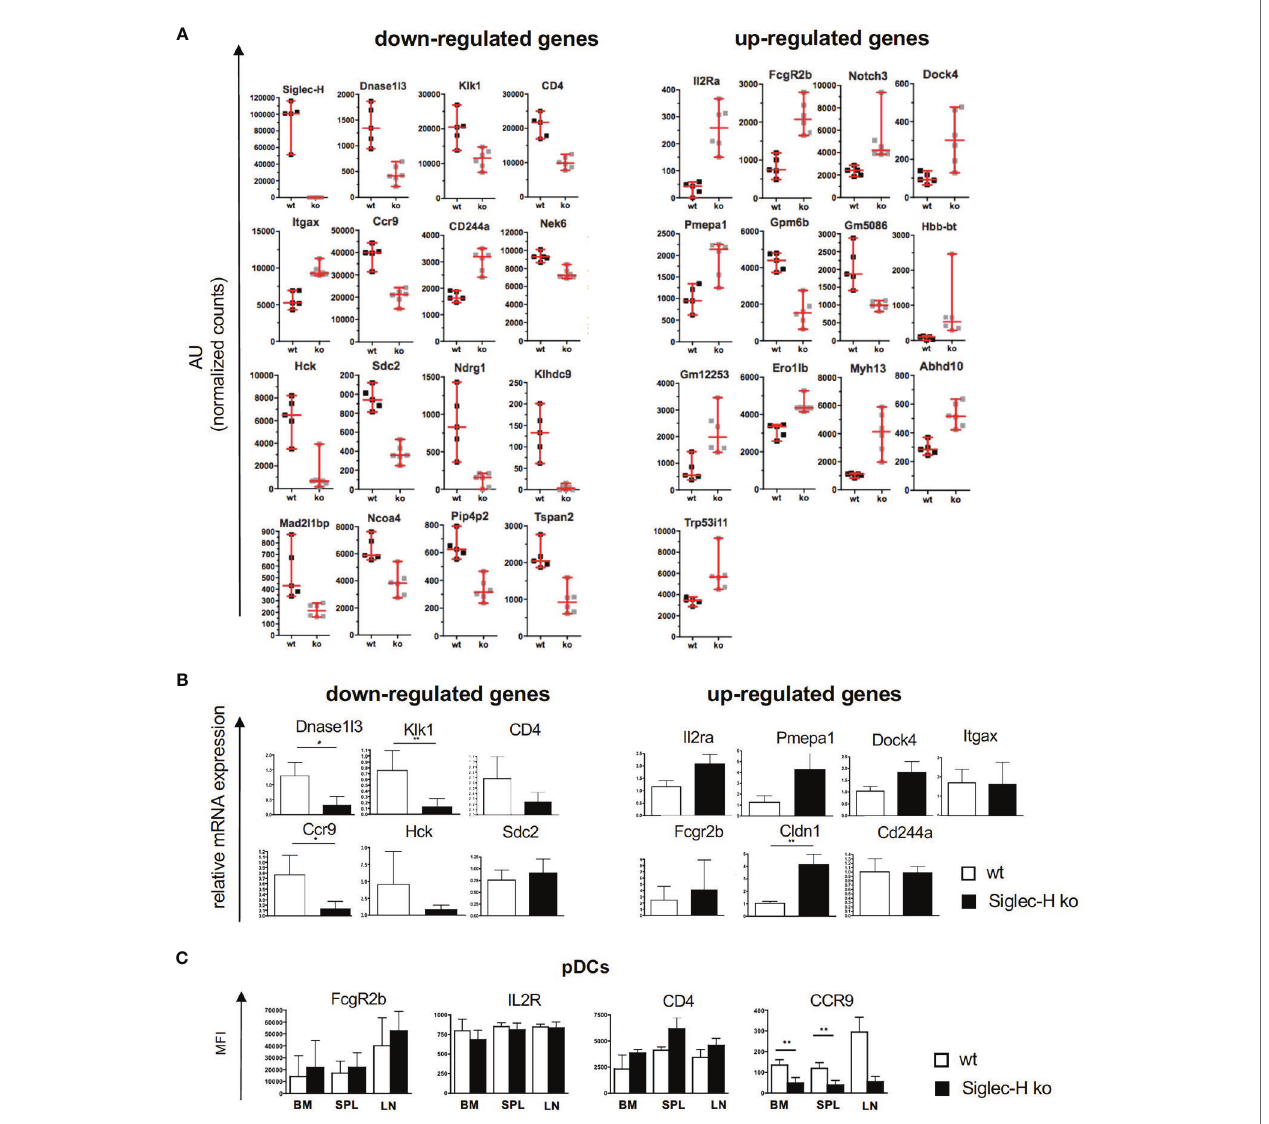
FIGURE 6 | Overview of down- and up-regulated genes in naive splenic Siglec-H ko pDCs. (A) Scatter plots displaying the relative gene expression in wt and Siglec-H ko pDCs from RNA sequencing samples as shown in Figure 4. Sequence counts per gene were normalized to total counts per sample (AU= arbitrary units). Vertical bars indicate median, error bars are mean ± SD values. (B) pDCs from wt and Siglec-H ko mice were sorted and relative mRNA expression was veri fi ed via qRT-PCR. Bar charts show a summary of fi ve independent experiments, n= 8-9. Mice were aged 8-14 weeks. Mann-Whitney test, *p < 0,05; **p < 0,01. Error bars are mean ± SD values. (C) Flow cytometric analysis of surface receptors on wt and Siglec-H ko pDCs in bone marrow (BM), spleen (SPL) and inguinal lymph nodes (LN). Bar charts display mean fl uorescence intensity (MFI). Summary of two independent experiments with n=5. Error bars are mean ± SD